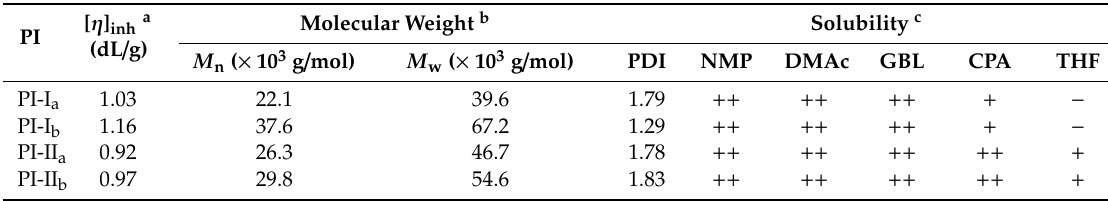
Table 1. Inherent viscosities, molecular weights, and solubility of SPI resins.